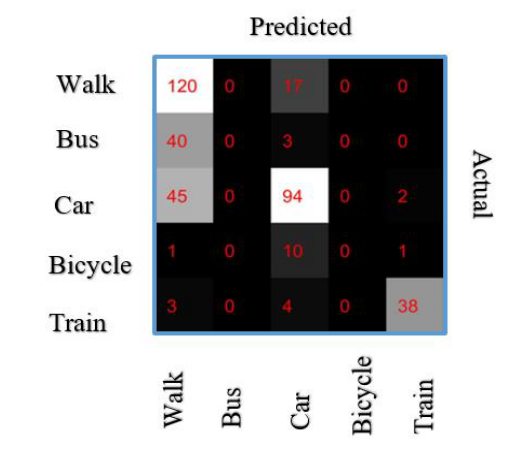
Figure 8 . Confusion matrix for LR classifier